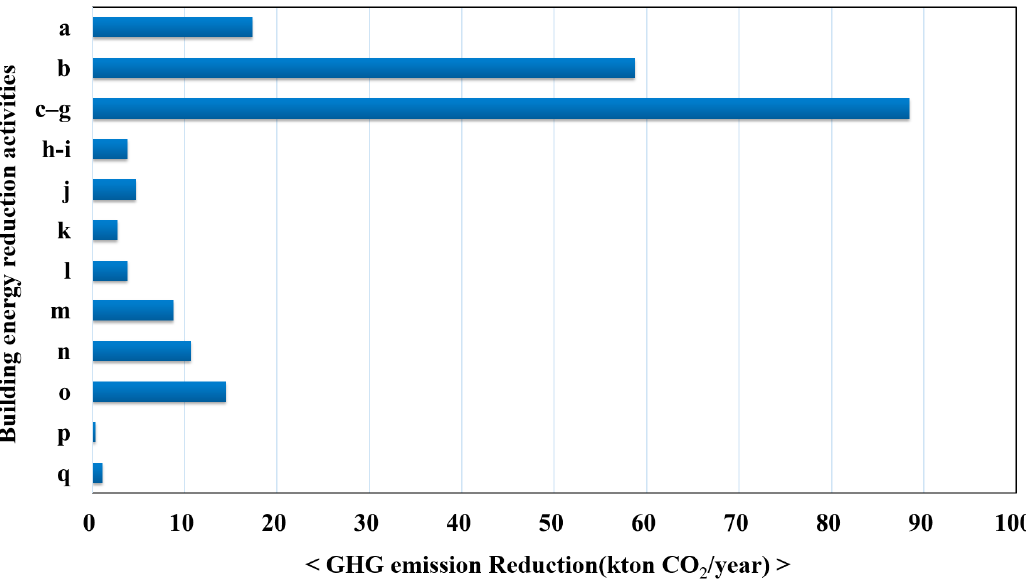
Figure 5. CO 2 emissions reduction potential for the building energy saving (BES) scenario.